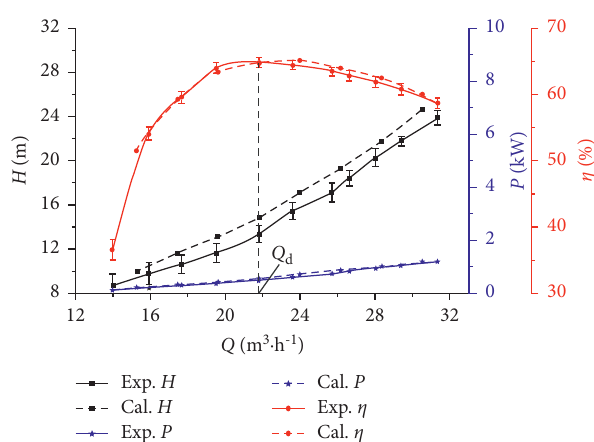
Figure 8: Numerical simulation and experimental test results of turbine model